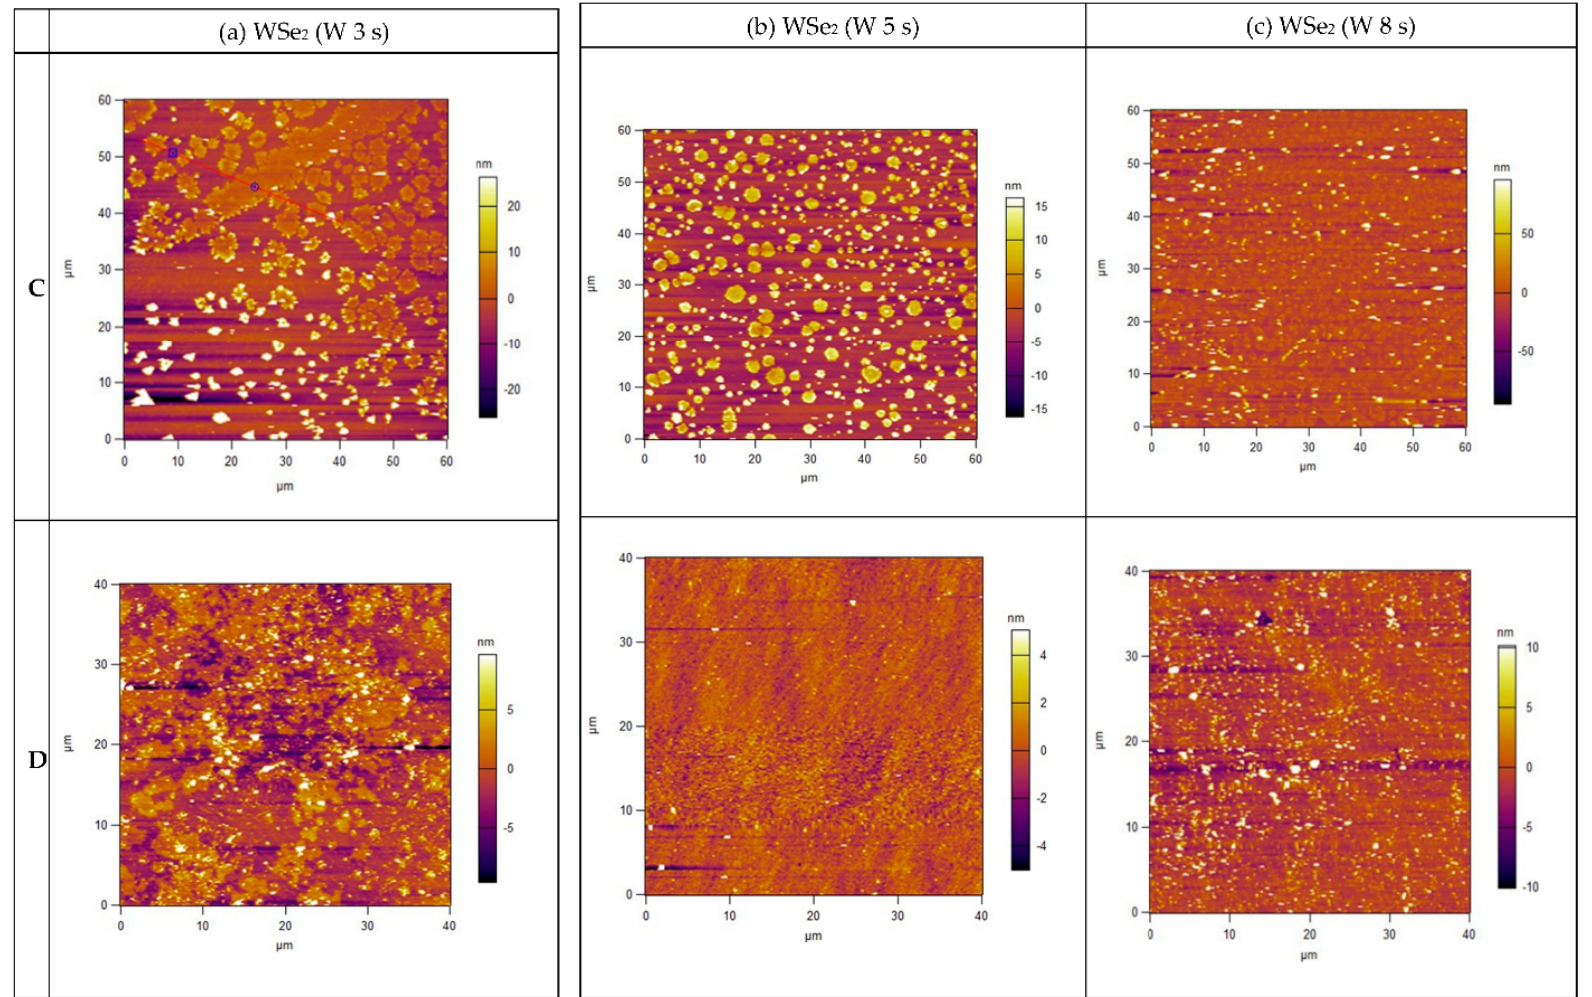
Figure 3. AFM images of WSe 2 flakes and continuous film for different pre-deposition time of W layers: ( a ) W 3 s, ( b ) W 5 s and ( c ) W 8 s (following vertical direction) at A, B, C and D sectors (A starts from the edge and moving to the center D) (following horizontal